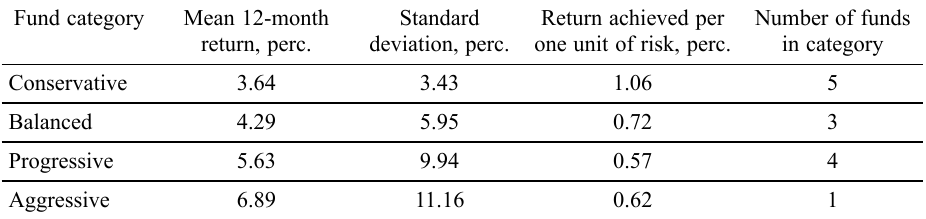
Table 13. Mean returns and standard deviations used in hypothesis testing Fund category